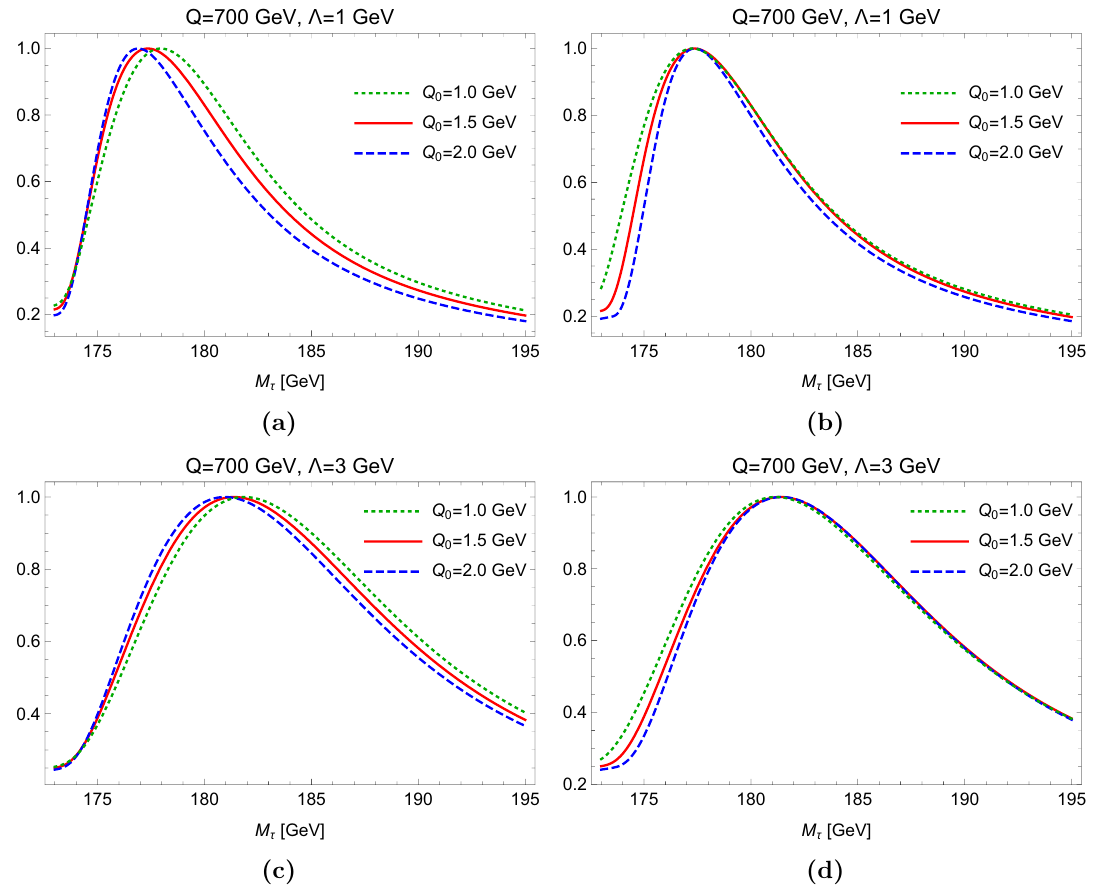
Figure 14. Parton level rescaled thrust distribution in the peak region obtained from Herwig 7 full simulations for Q = 700 GeV and smearing with (cid:3) = 1 GeV (upper panels) and (cid:3) = 3 GeV (lower panels) for shower cut values Q 0 = 1 GeV (dotted green curves), Q 0 = 1 : 5 GeV (solid red curves) and Q 0 = 2 GeV (dashed blue curves). Left panels: simulations with generator input mass m t = 173 GeV and using the same soft model shape function for all shower cut values. Right panels: same distributions, but using a Q 0 -dependent soft function gap to eliminate the shower cut dependence due to large angle soft radiation and using m CB ( Q 0 = 1 : 0) = 173 : 22 GeV (green), m CB ( Q 0 = 1 : 5) = 173 GeV (red) and m CB ( Q 0 = 2) = 172 : 86 GeV (blue) as the generator